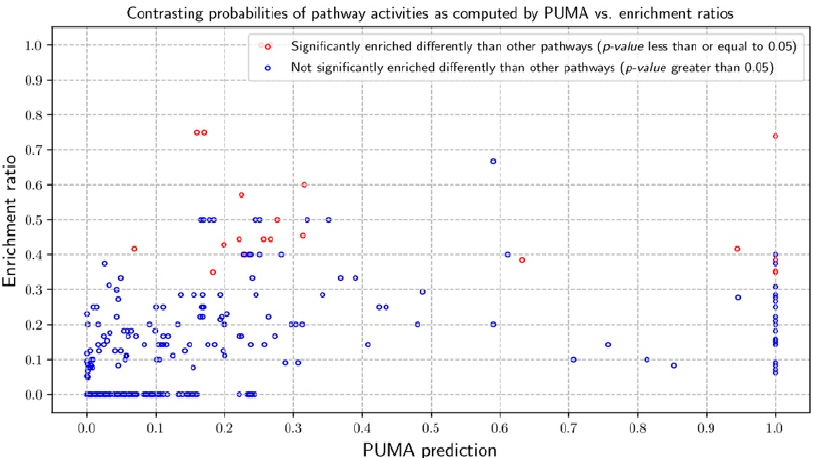
Figure 7. Probability of pathway activities as computed by PUMA vs. enrichment ratios for the human urine sample. Each data point is marked as either statistically enriched (red) or non-statistically enriched (blue) based on a Fisher’s Exact Test p- values of 0.05.